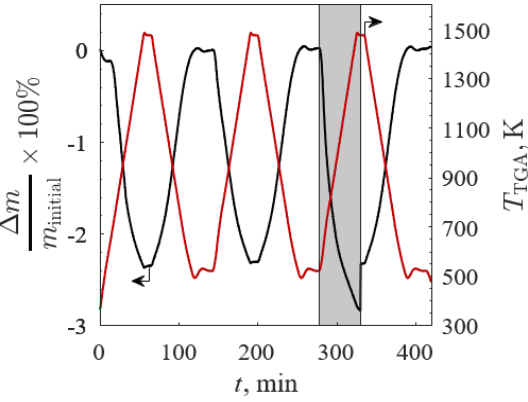
Figure 8. Relative mass change (black line) and temperature (red line) versus time of Ba 0.2 Sr 0.8 Co 0.2 Fe 0.8 O 3−δ between 523 and 1473 K in 20% O 2 /Ar and 100% Ar (gray region) for TGA Screening 2.